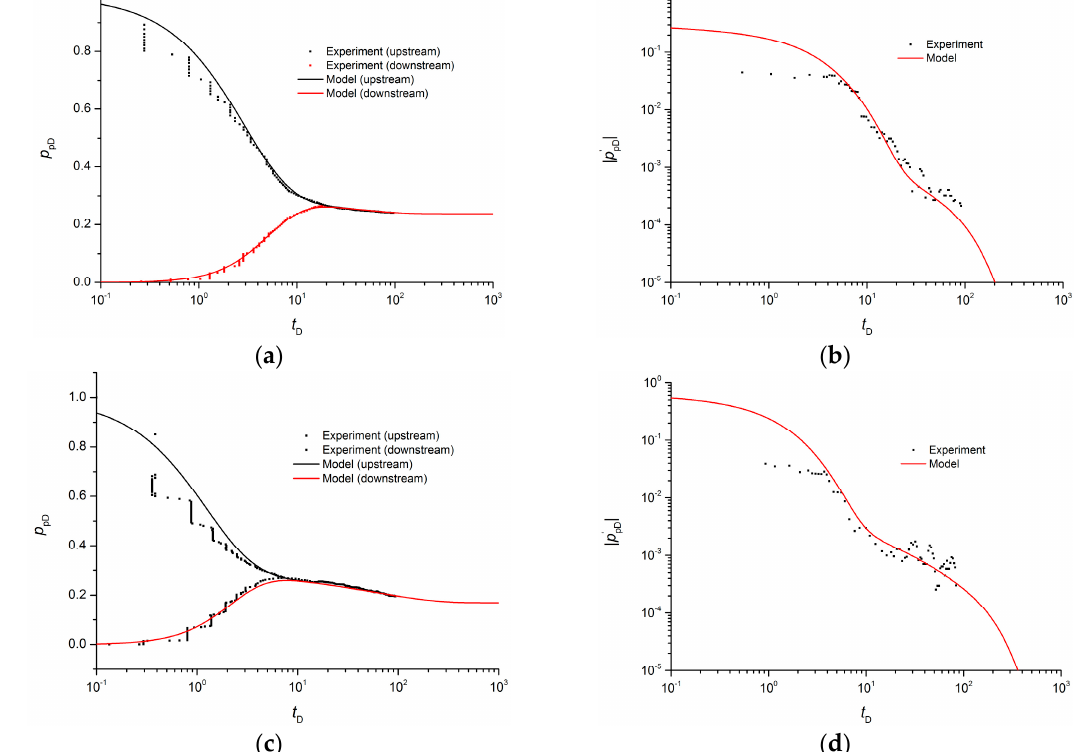
Figure 20. Comparisons between the simulation results and the experiment of Barnett 26-Ha. ( a ) Pressure histories of N 2 . ( b ) Pressure derivative histories of N 2 . ( c ) Pressure histories of CH 4 . ( d ) Pressure derivative histories of CH 4 . (Experimental data from Aljamaan et al. [16])